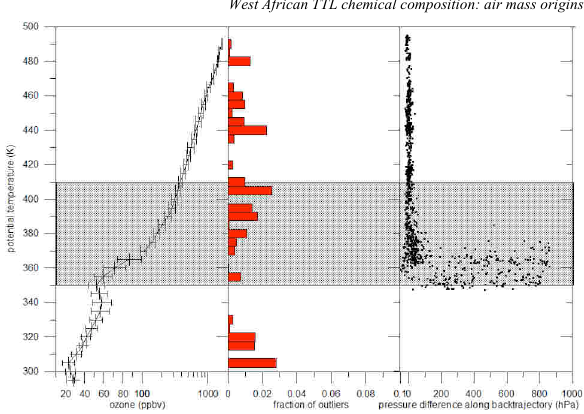
Figure 12: Leftmost profile, average ozone concentrations (ppbv) using M55 data collected south of 17.5N versus potential temperature (K), bars denote one standard deviation; note the linear (< 100 ppbv)/ log (> 100 ppbv) horizontal axis for ozone. Middle bar chart, fraction of ozone data points lying outside three standard deviations from the mean, versus potential temperature; Rightmost panel, pressure difference (hPa) along 10-day back trajectories arriving along M55 flights (south of 17.5N) versus potential temperature (K). Grey shading denotes the TTL region.